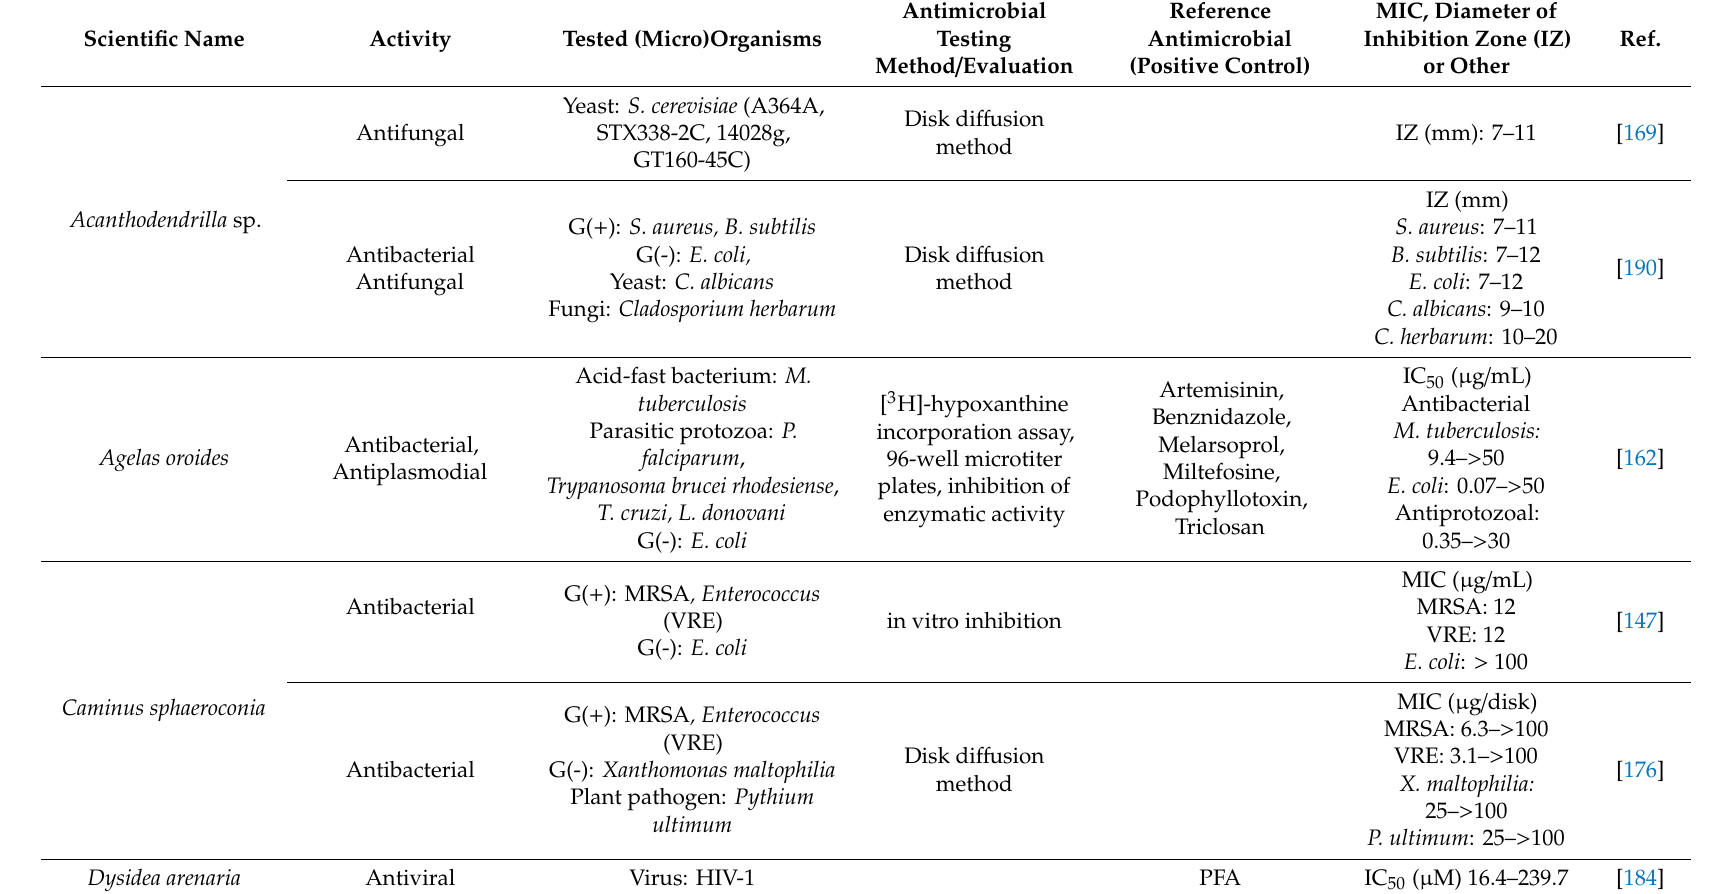
Table 6. Antimicrobial activity of lipids or lipid-rich extracts from marine